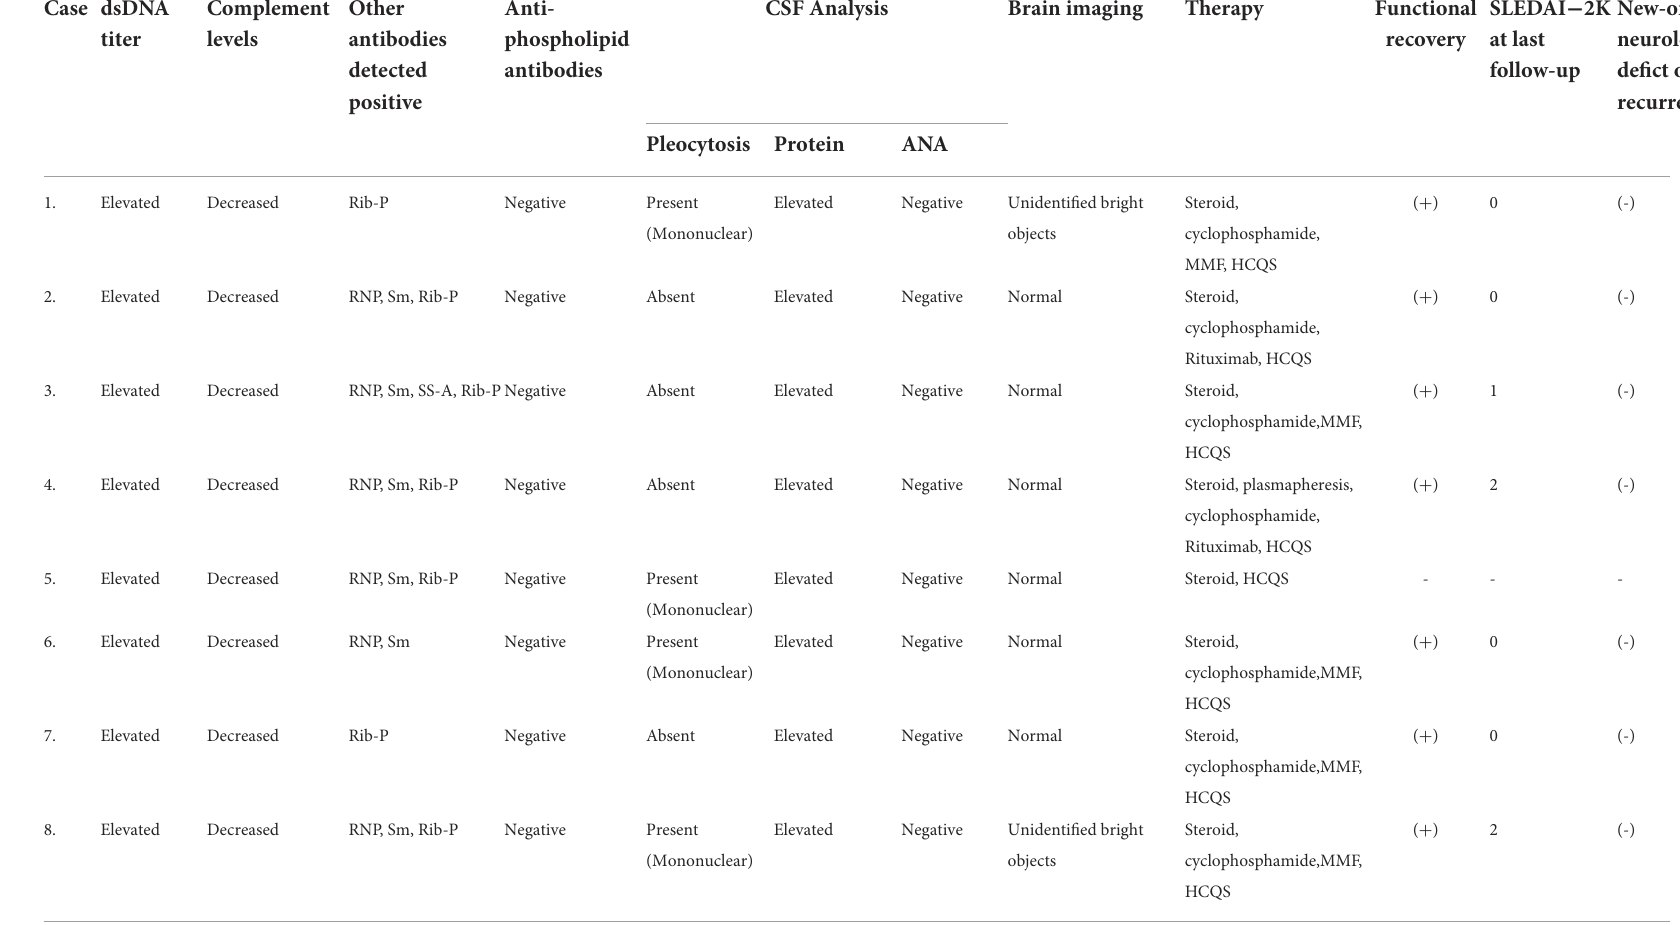
TABLE 2 Investigational details, mangement and follow-up of our cohort of MRI-negative myelitis in